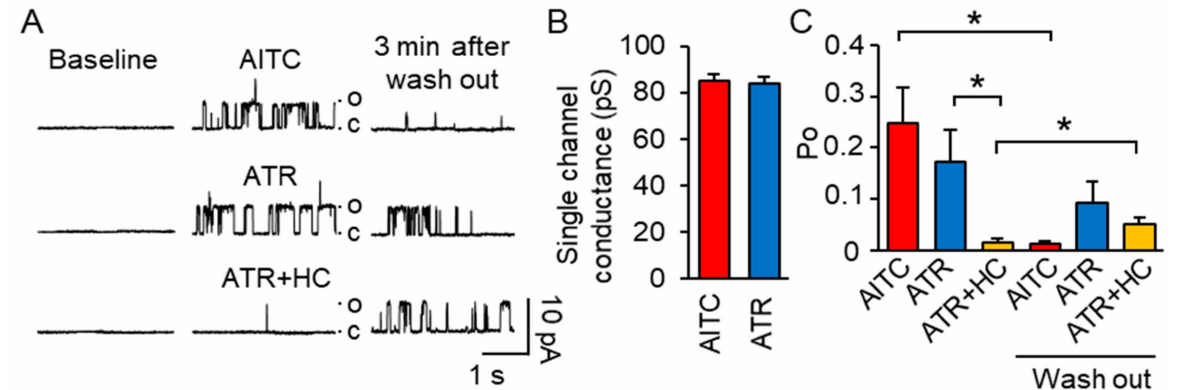
Figure 2. Bath application of atractylodin induced long-lasting TRPA1 channel activation in the hTRPA1 transfected HEK cells. ( A ) Sample traces illustrate TRPA1 single-channel currents induced by AITC (top, n = 4), ATR (middle, n = 6), and ATR + HC (bottom, n = 6) on the hTRPA1 expressing HEK293 cell recorded by cell-attached configuration. Holding potential was 60 mV. ( B ) Bar graph shows single-channel conductance. ( C ) Summary of the open probability of TRPA1 channel before and after washing out of AITC, ATR, or ATR+HC. Data represent mean ± standard error of mean, * p < 0.05, one-way analysis of variance with the Tukey post hoc test or Student’s t -test. AITC: allyl isothiocyanate; ATR: atractylodin; HC: HC-030031: Po: open